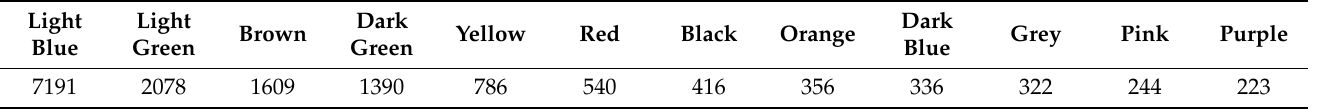
Table 4. Total surface colour (cm 2 ) with each of the twelve different felt-tip pens that the children had at their disposal in the two pictorial activities ( n =